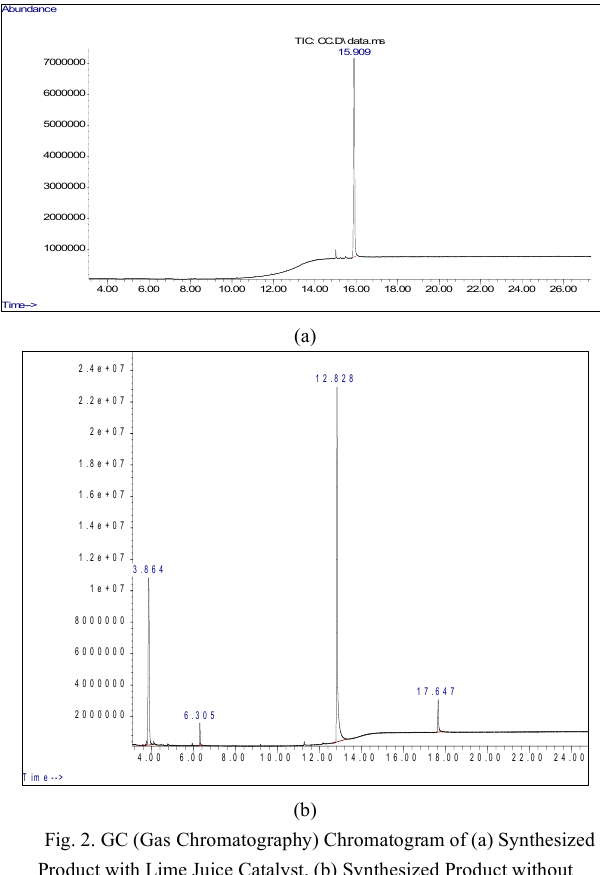
Fig. 2. GC (Gas Chromatography) Chromatogram of (a) Synthesized Product with Lime Juice Catalyst, (b) Synthesized Product without Catalyst The 151 m/z and 123 m/z fragments due to the discharge of 1 H and the aldehyde group (-CHO) also strengthened that presumption. Meanwhile, the third peak with 12.828 minutes retention time and 56.71% area was assumed to be Compound 2 (2-(4-hydroxy-3 methoxybenzylidene) cyclohexane-1,3- dione, resulted from the first Knoevenagel's condensation between 1,3-cyclohexanedione and vanillin, as a peak with m/z 246 value appeared along with the presence of m/z 231 and m/z 215 fragments caused by the discharge of methyl and methoxy groups. The fourth peak was observed to have 17.647 minutes retention time, and 5.28% area was expected to be